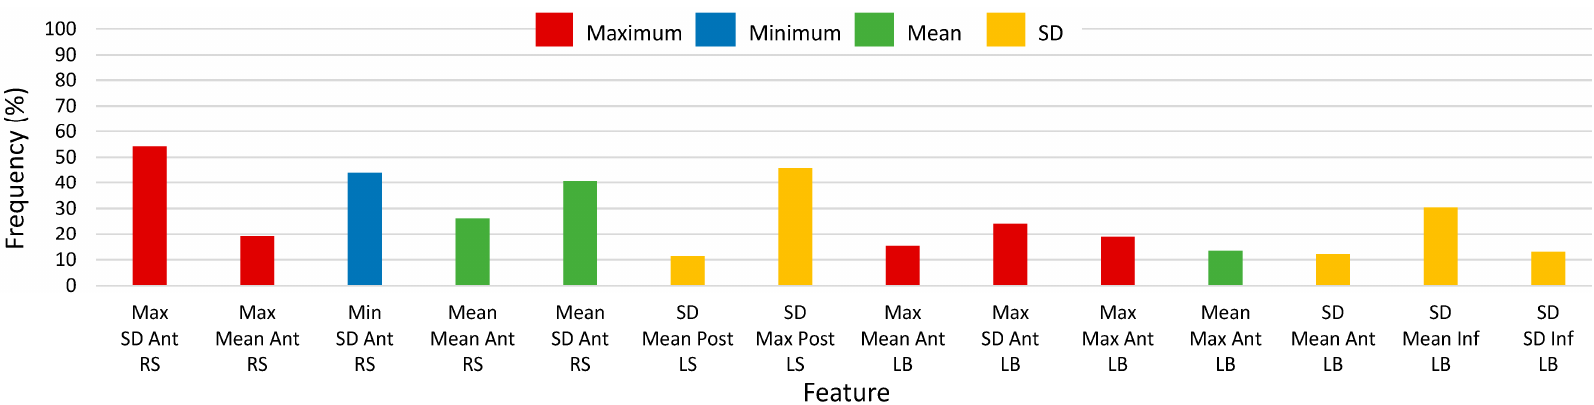
Figure 7. Histogram of selected straight-walking feature frequency above 8% (200) of 2500 total selections using the select-5-best (S5B) method for 2500 random-shuffle-split iterations.